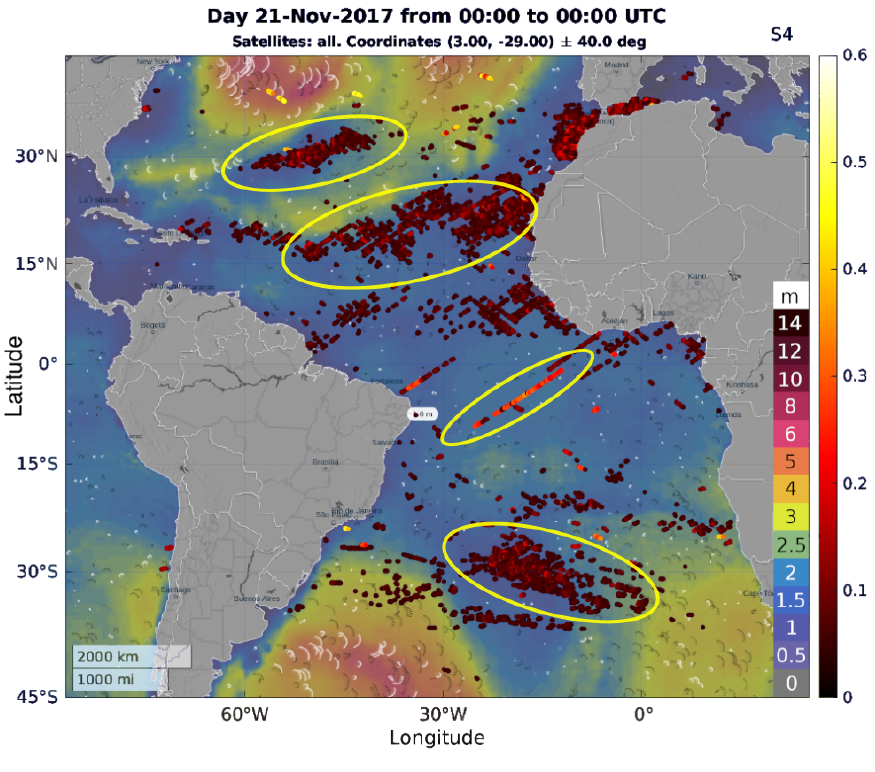
Figure 6. S 4 values above 0.05 over Atlantic ocean for 21 November 2017. It can be see that most of the S 4 points appear only when the ocean is relatively